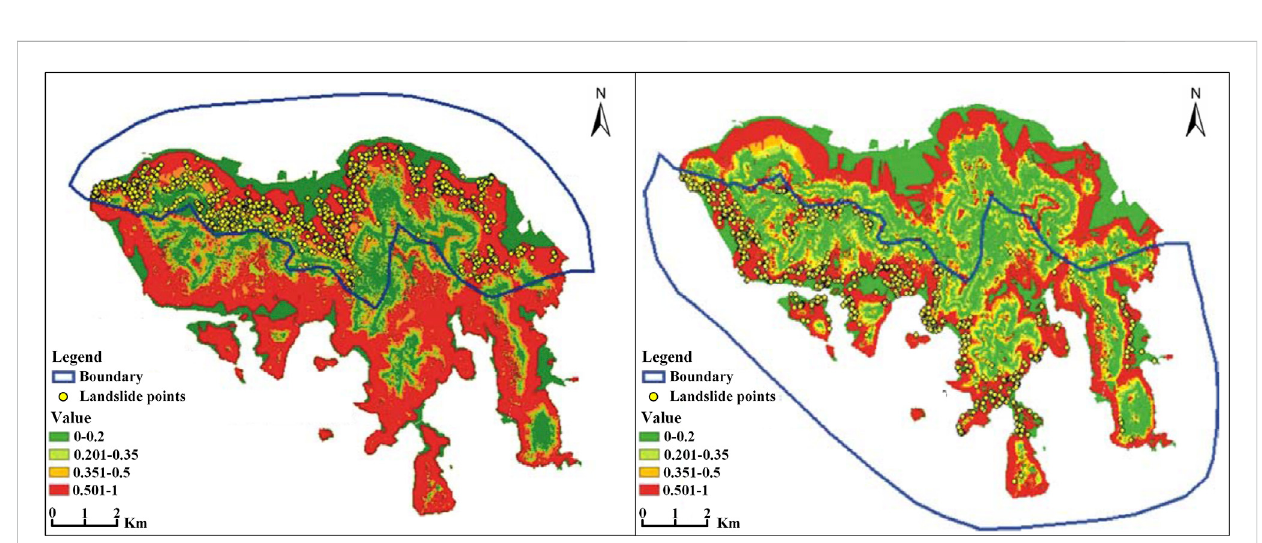
FIGURE 6 LandslidesdistributioninHongKongIsland.Landslidesaredenseinthenorthandsparseinthesouth,andtheheterogeneityinlandslidedistributions produces different susceptibility prediction results accordingly (Chau and Chan,